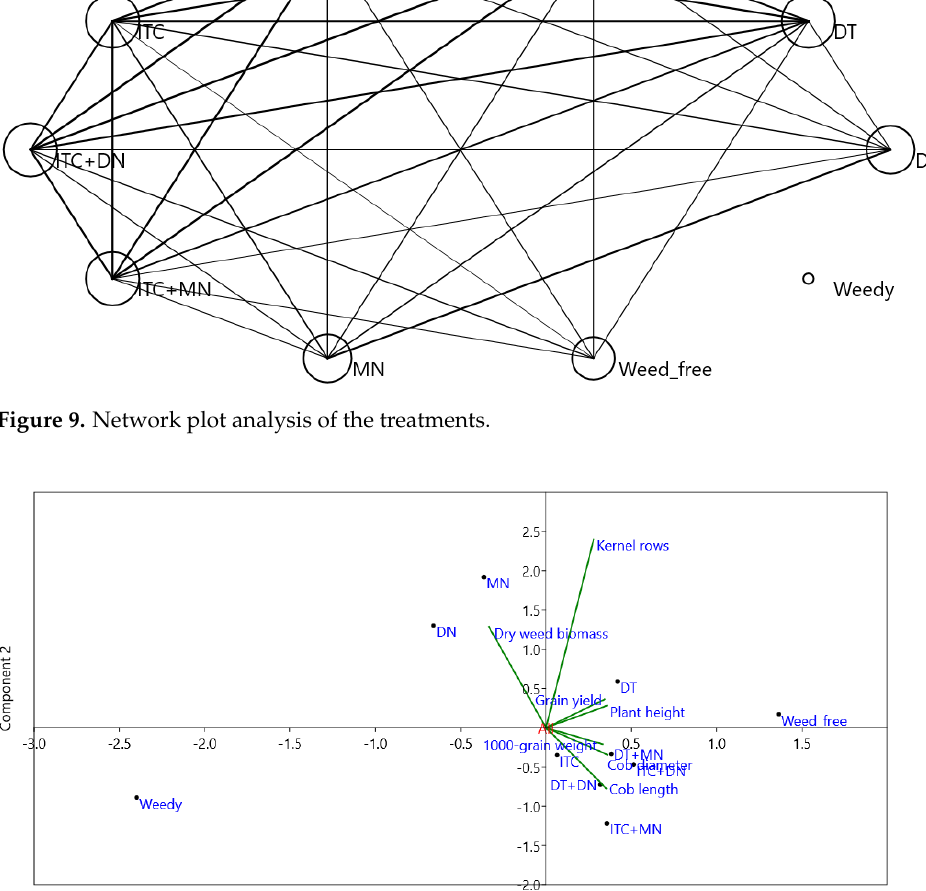
Figure 10. Principal component analysis of the parameter and